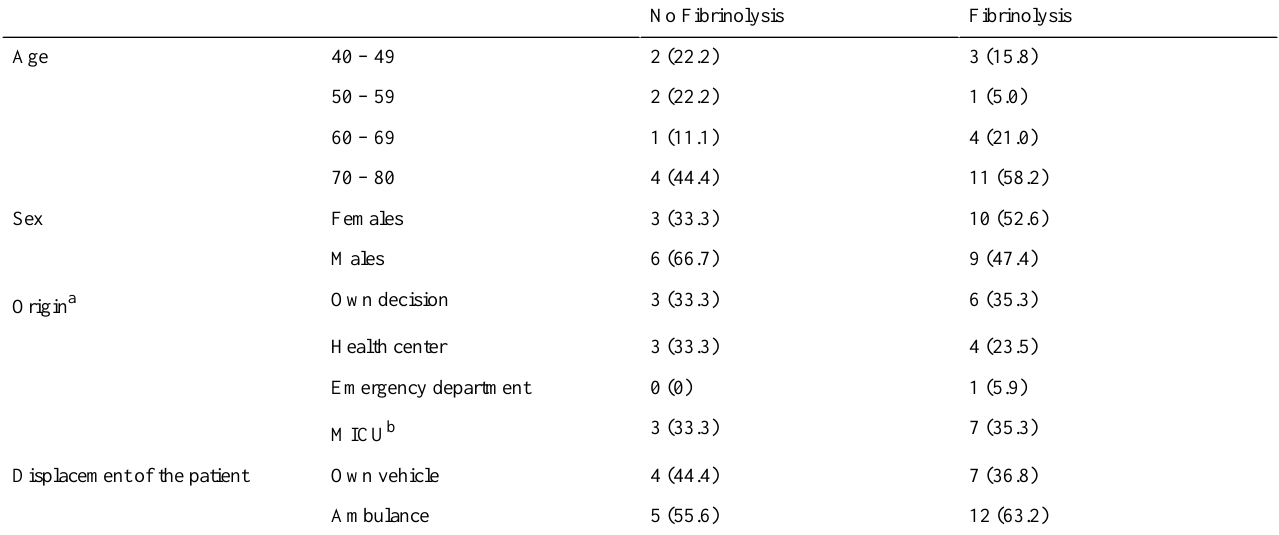
Table 2. Characteristics of patients; data are presented as n (%).